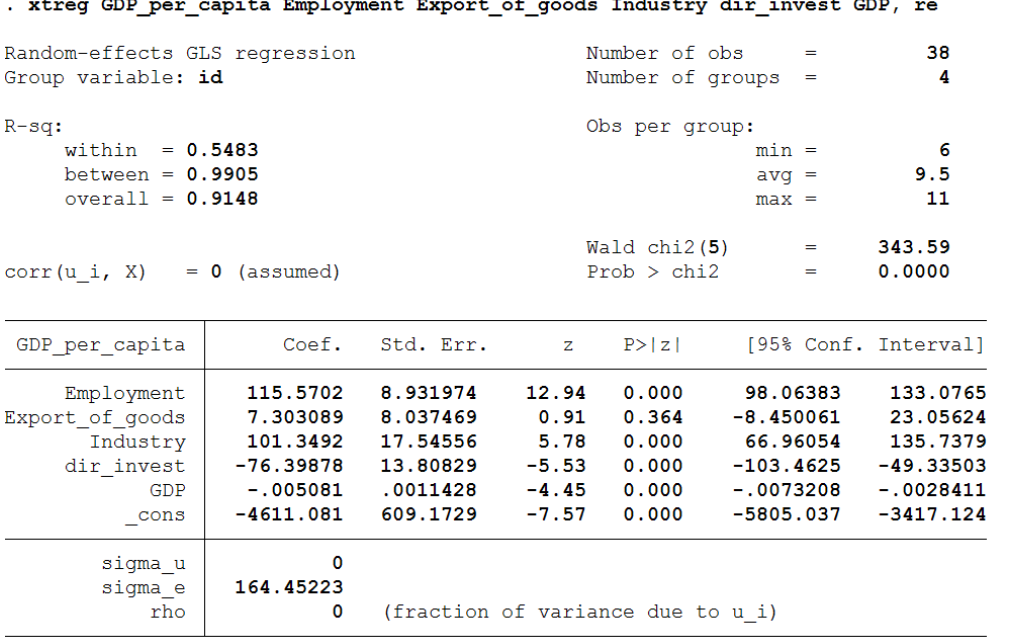
Figure 3. Results of the assessing the impact of financialization on the level of economic development in the countries trying to join the EU (random